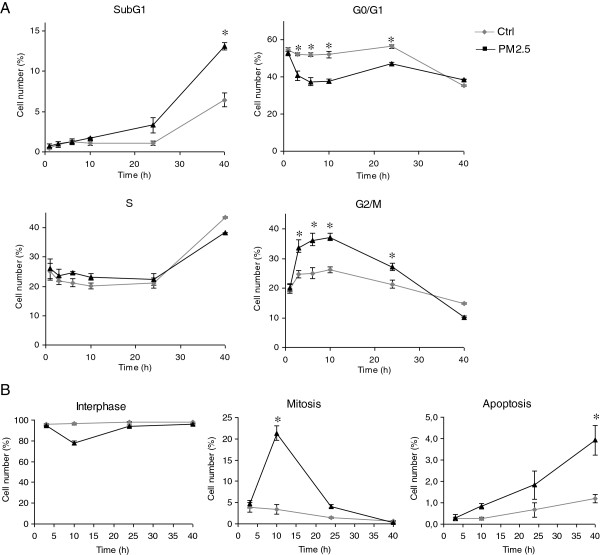
Cell cycle analysis. (A) Cell cycle of BEAS-2B cells exposed to 7.5 μg/cm2 of winter PM2.5 for 1, 3, 6, 10, 24 and 40 h. The results are representative of 4 independent experiments. (B) Mitotic cells scoring: BEAS-2B cells, exposed for 3, 10, 24 and 40 h to 7.5 μg/cm2 of winter PM2.5, were stained for DNA and β-tubulin and scored as interphasic, mitotic or apoptotic cells. The results are representative of 3 independent experiments; in each experiment 500 cells were scored. * Statistically significant difference from untreated cells (control), P < 0.05.